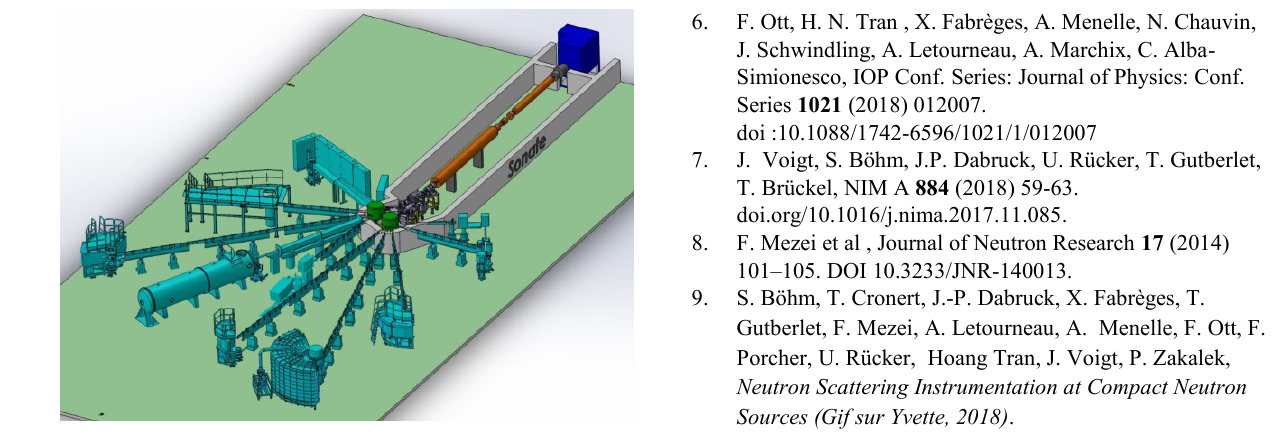
Fig. 7. A possible sketch of SONATE. A first long pulse / low repetition rate target station (green) would serve low resolution instruments such as an imaging station, a SANS, a reflectometer, a spin-echo and a low resolution powder diffractometer. A second target station with short pulses and high repetition rate would serve higher resolution instruments such as a direct TOF instrument, a high resolution powder diffractometer, an inverse TOF